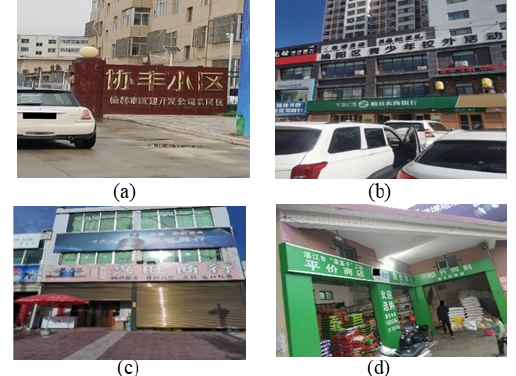
Figure 1 . Examples of street-level imagery containing POI information. (a) residual area; (b) bank; (c) and (d) shops.